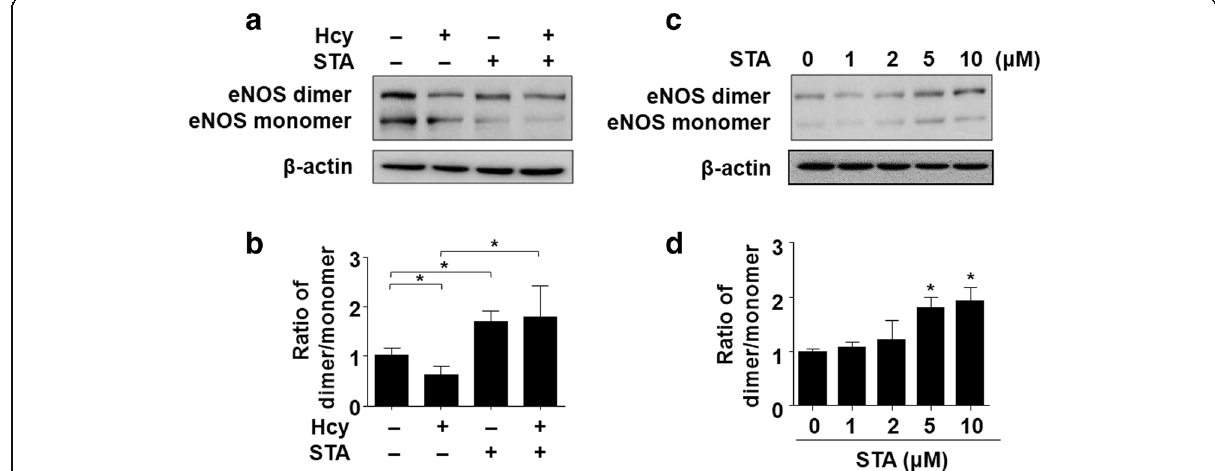
Fig. 4 STA ameliorated Hcy-induced eNOS uncoupling. a BAECs were pre-incubated with STA (10 μ M, 12 h) or vehicle and, then exposed to Hcy (500 μ M, 12 h). Protein levels of eNOS dimers and monomers were detected by using low-temperature SDS-PAGE/western blotting. c BAECs were exposed to indicated concentrations of STA for 24 h, cell lysates were analyzed to determine eNOS dimers and monomers protein levels. b and d Quantification of eNOS dimer/monomer levels. Data were shown as mean ± SEM, n = 5. * P <